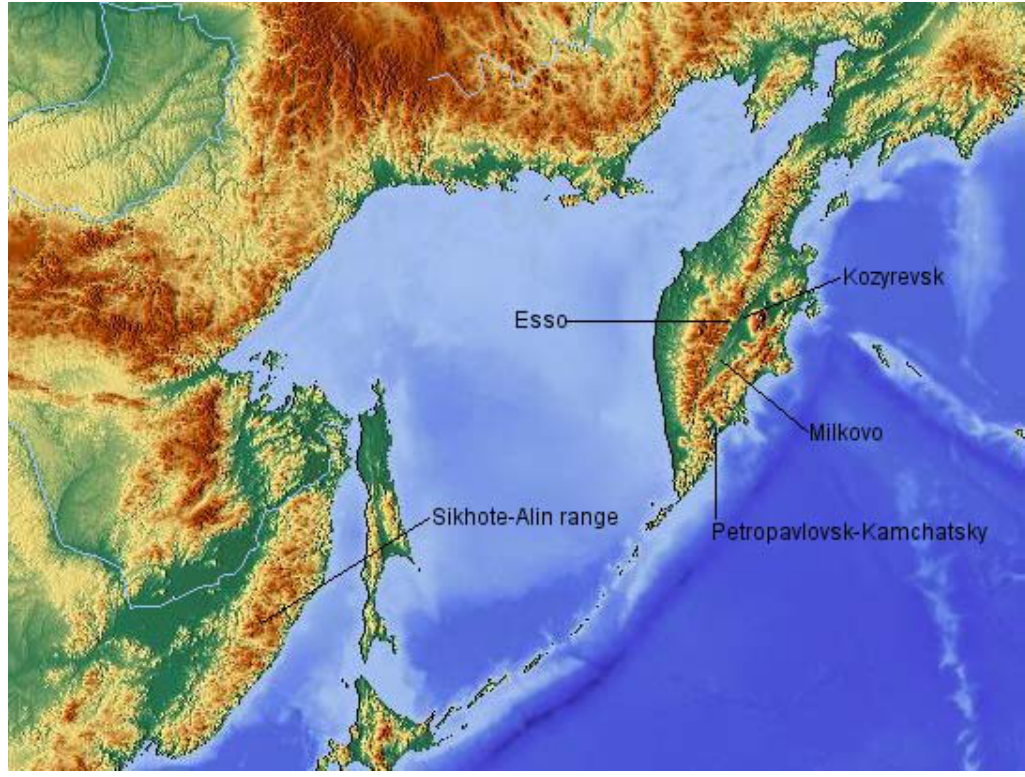
Figure 1. Regional map of Far East Russia with locations referred to in the